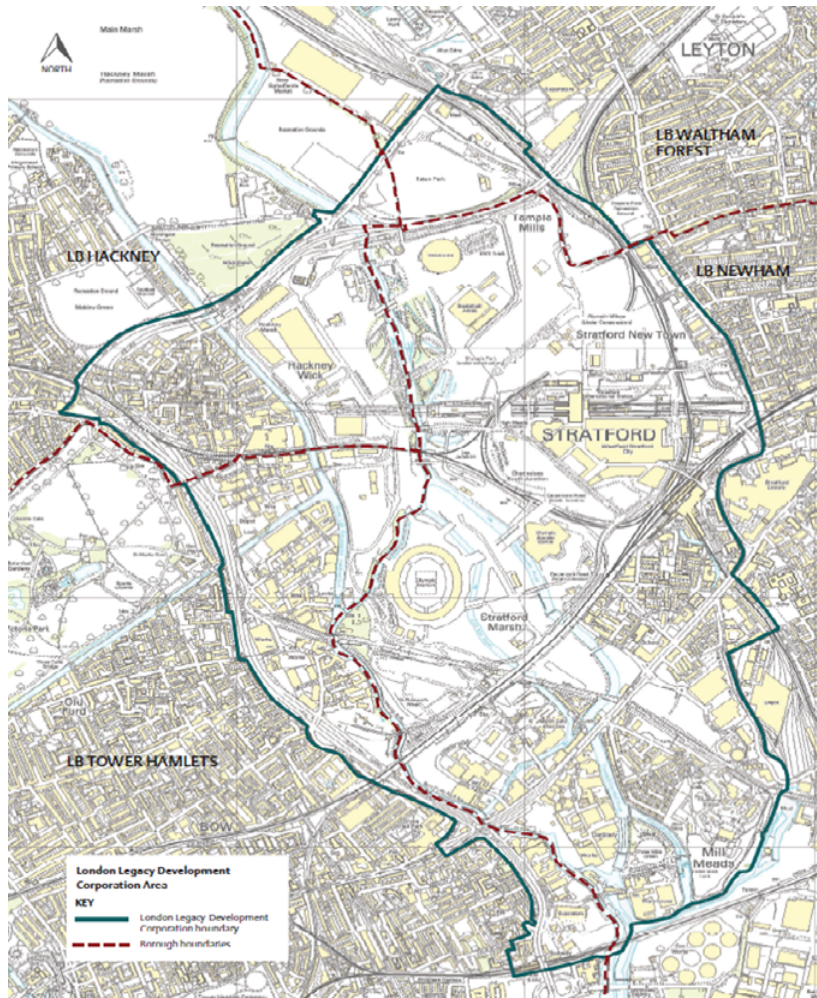
Figure 3. LLDC’s Planning Boundary: “Planning Area Map,”